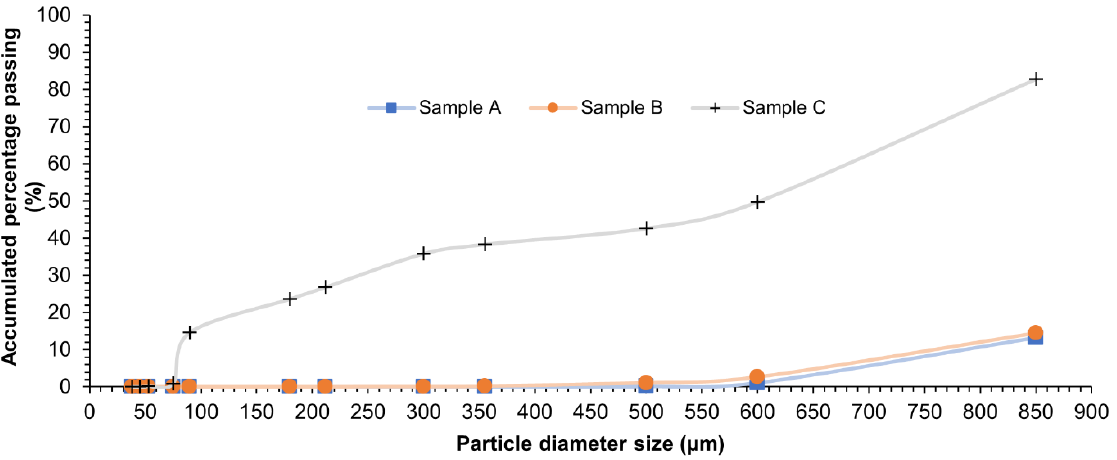
Figure 1. Particle size distribution (granulometric curve) of CARBOSORB NC 1240 ® (sample A), AMBIOTON ® (sample B), and RE-CHAR ® (sample C).